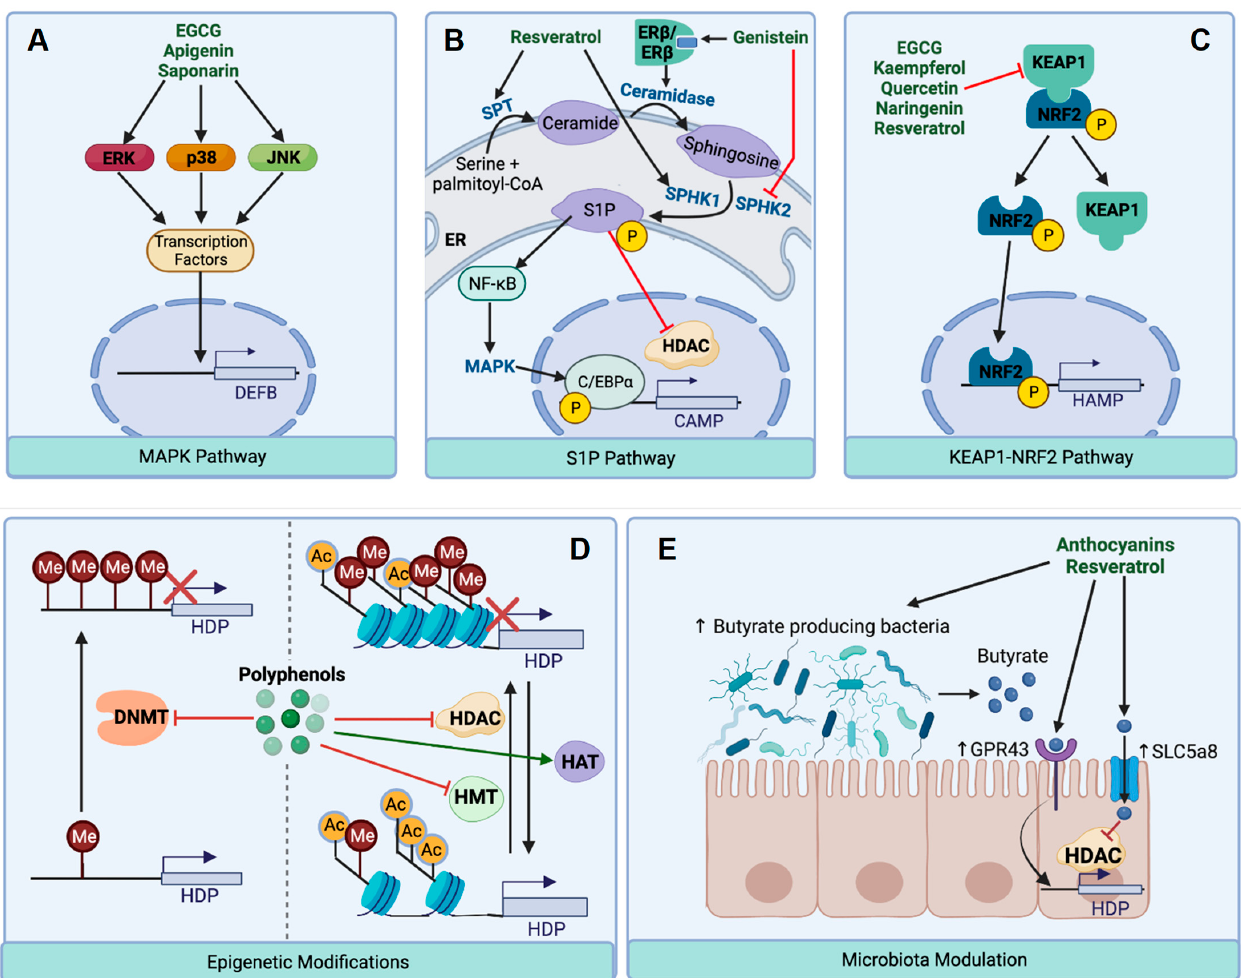
Figure 3. Molecular mechanisms of polyphenol-mediated induction of host defense peptide (HDP) genes. Certain polyphenols are shown to activate the MAPK pathway to upregulate the expression of human β -defensin ( DEFB ) genes ( A ). Resveratrol and genistein enhance sphingosine-1-phopshate (S1P) synthesis and NF- κ B activation to induce cathelicidin antimicrobial peptide ( CAMP ) gene ex- pression ( B ). Several polyphenols inhibit KEAP1 to allow nuclear translocation of NRF2 to induce the expression of hepcidin antimicrobial peptide ( HAMP ) ( C ). Many polyphenols function as inhibitors of histone deacetylase (HDAC), DNA methyltransferase (DNMT), or histone methyltransferase (HMT) to increase histone acetylation while reducing DNA and histone methylation to promote a relaxed chromatin structure in favor of HDP transcription ( D ). A few polyphenols directly enhance the histone acetyltransferase (HAT) activity to promote HDP transcription ( D ). HDP gene expression may be enhanced by polyphenols through modulating the synthesis of metabolites, such as butyrate, by the intestinal microbiota ( E